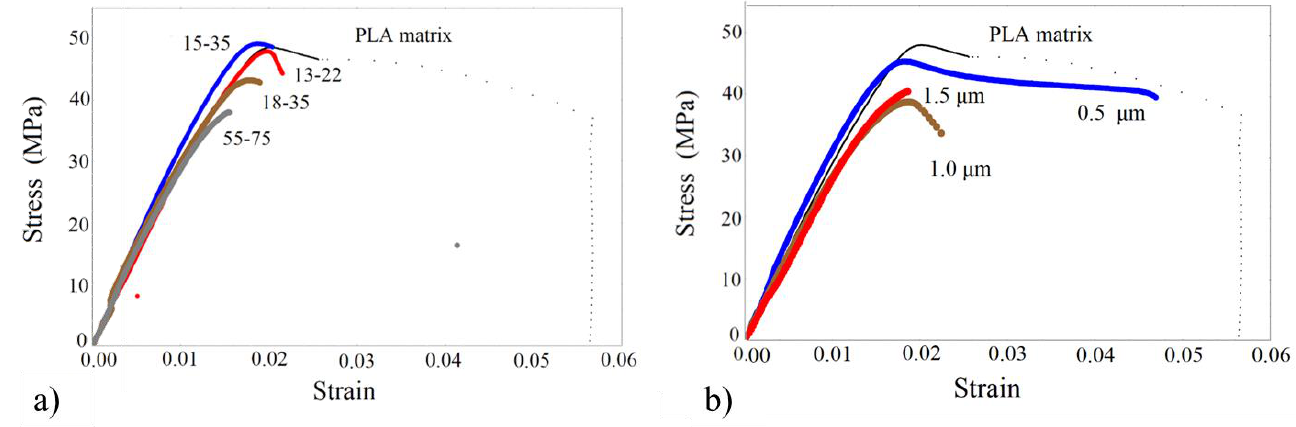
Figure 4. SEM micrographs of Resin/SiO 2 nano-composites, ( a ) Resin/13-22, ( b ) Resin/15-35, ( c ) Resin/18-35, ( d ) Resin 55-75.